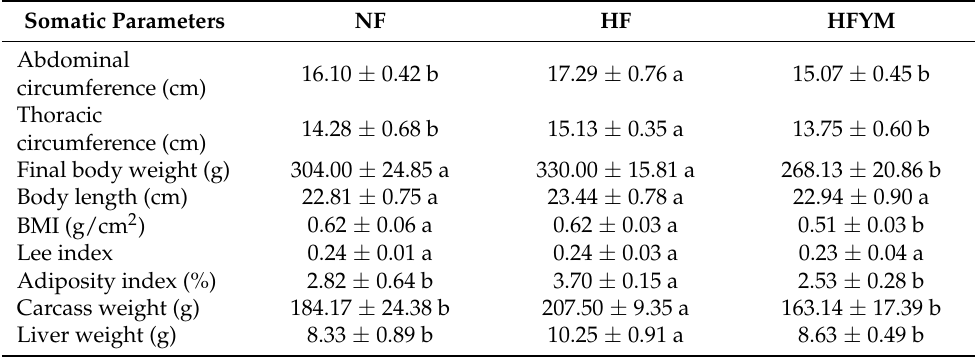
Table 2. Somatic parameters of rats fed a normal-fed or high-fat diet and supplemented or not with yellow mombin.